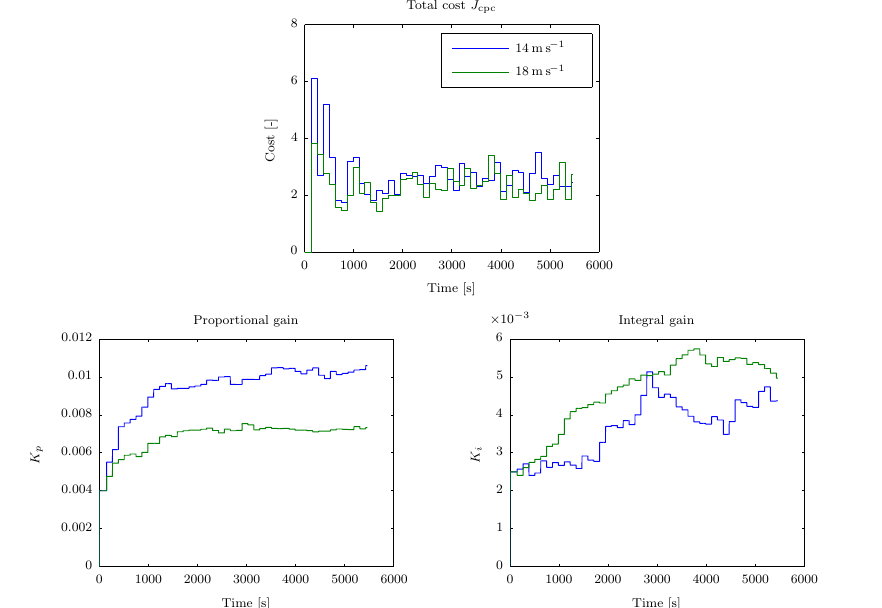
Figure 17. Reference step tuning of CPC using IFT of CPC at a wind speed of 14ms − 1 with 4% turbulence intensity.